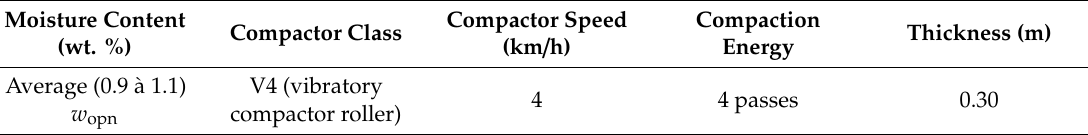
Table 7. Optimal compaction conditions of I2